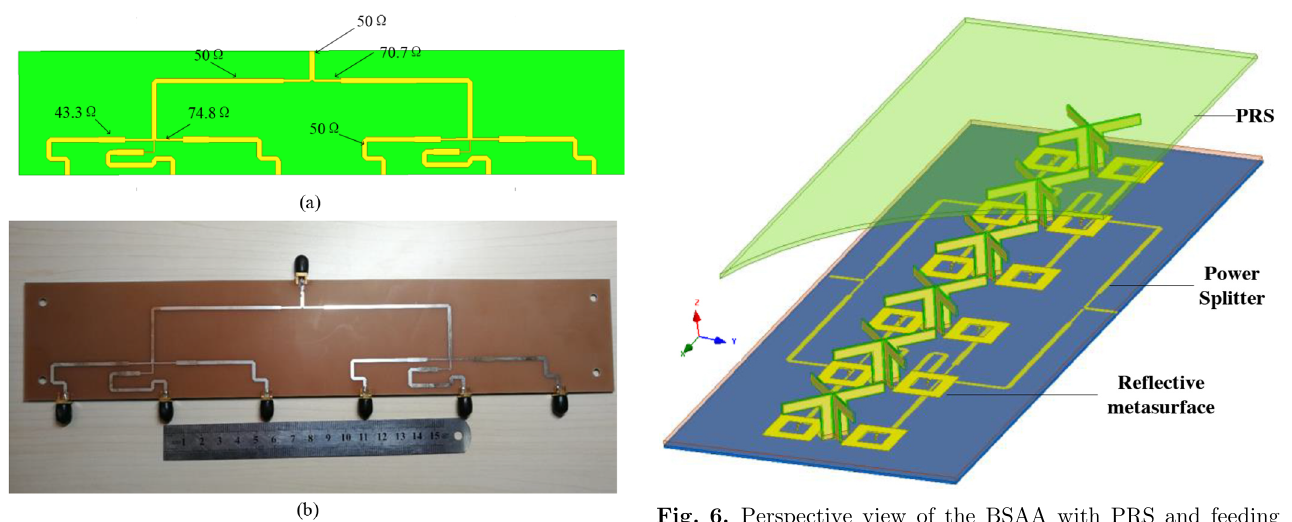
Fig. 5. (a) Geometry of the power splitter, (b) prototype of the power splitter.